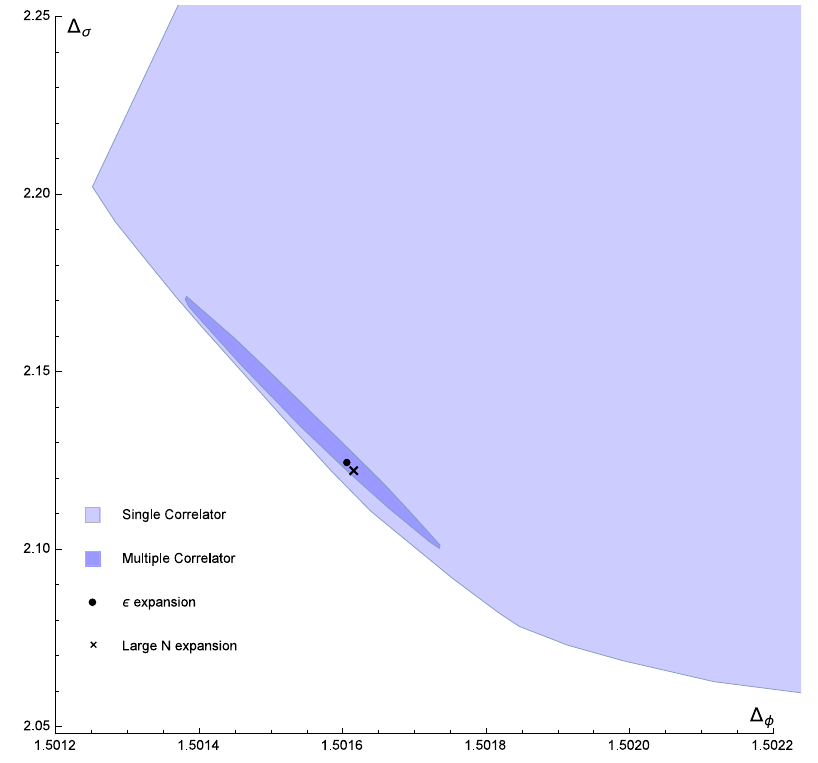
Figure 4 . Bounds on the conformal dimensions ((cid:1) (cid:30) ; (cid:1) (cid:27) ) in 5 D O (100) vector model. The light blue region is obtained from single correlator bootstrap. The multiple correlators bootstrap leads to a small island colored in dark blue. In the bootstrap program we adopt the setup with (cid:3) = 19 and the correspond spins provided in (3.9). We apply a dimension gap (cid:1) (cid:3) = 3 : 6 in the S-channel. S; 0 Besides, an extra dimension gap (cid:1) (cid:3) = 5 has been used in the V-channel for bootstrapping V; 0 multiple correlators. The black dot and cross relate to the predictions from (cid:15) expansion and large N expansion,